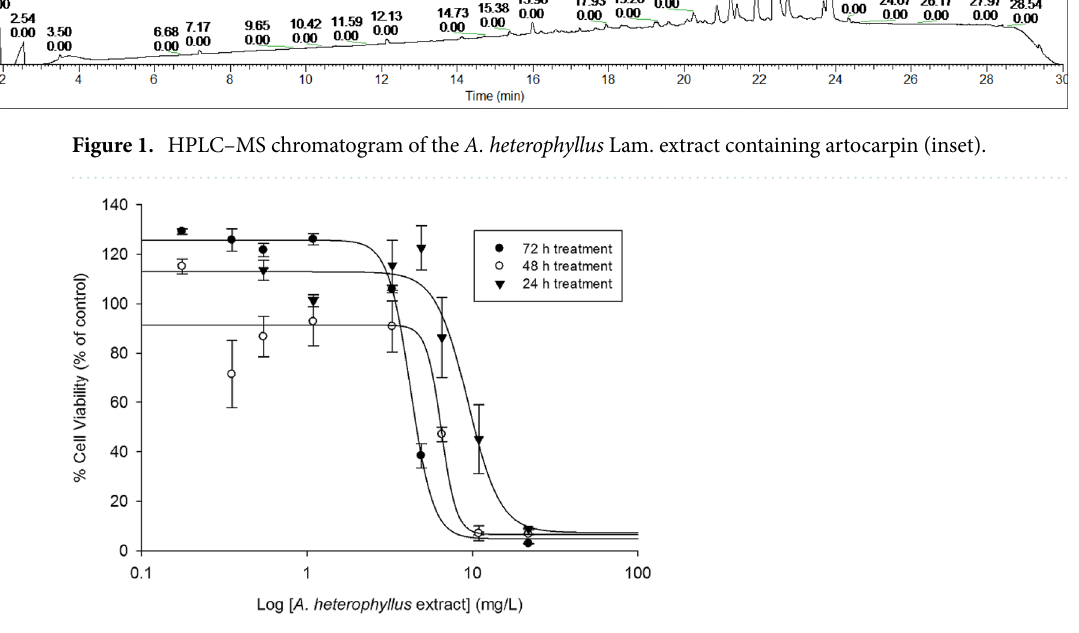
Figure 2. Cytotoxicity of the A. heterophyllus extract toward human colon adenocarcinoma HCT116 cells. The cells were treated with the A. heterophyllus extract for 24 h, 48 h, and 72 h, and the cell viability, as a percentage relative to the solvent (ethanol)-treated control, was measured using the MTT assay as detailed in the methods. Data are presented as the mean ± SEM of three independent